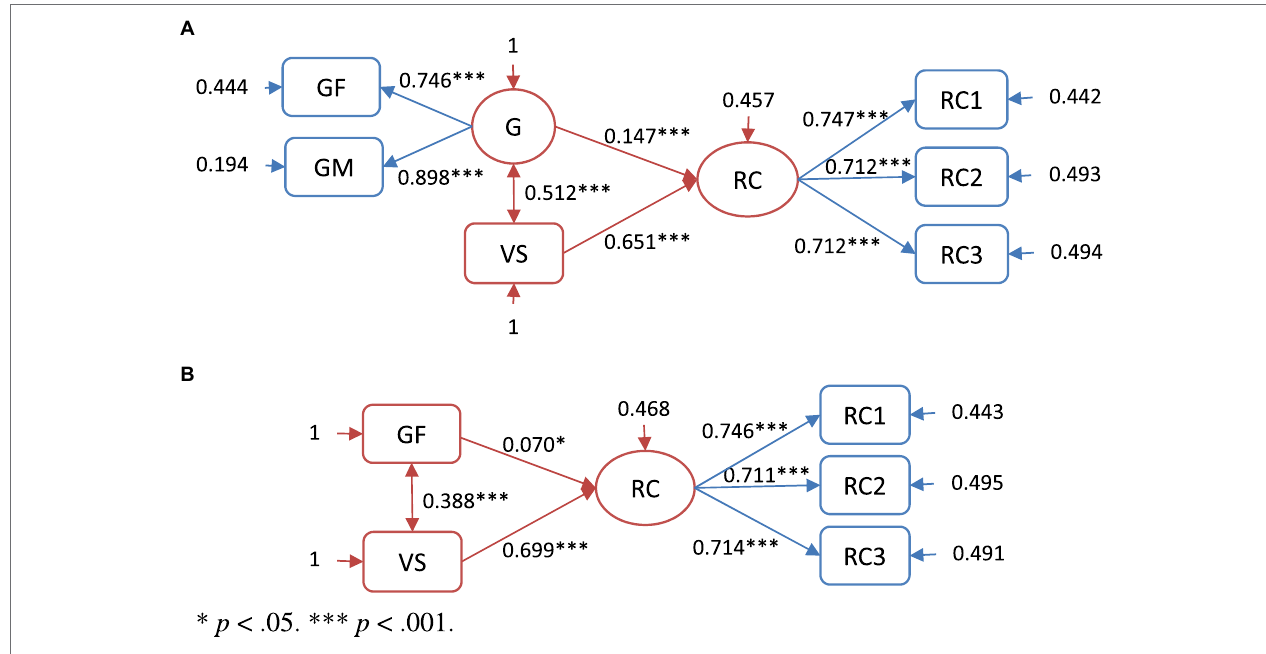
FIGURE 2 | (A) The basic regression model. (B) The GF regression model. * p < 0.05, *** p <